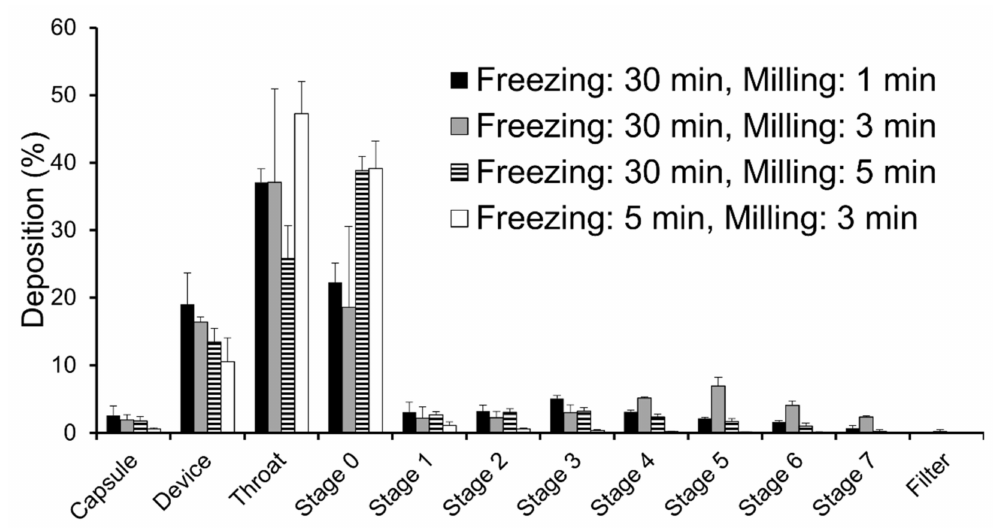
Figure 2. Deposition patterns of the milled nanofiber mats in an eight-stage Andersen cascade impactor. Freezing: 30 min, milling: 1 min (black); freezing: 30 min, milling: 3 min (gray); freezing: 30 min, milling: 5 min (stripe); and freezing: 5 min, milling: 3 min (white). Each value represents the mean ± standard deviation (SD; n = 3). Table 2. Aerosol performance of the milled nanofiber mats.